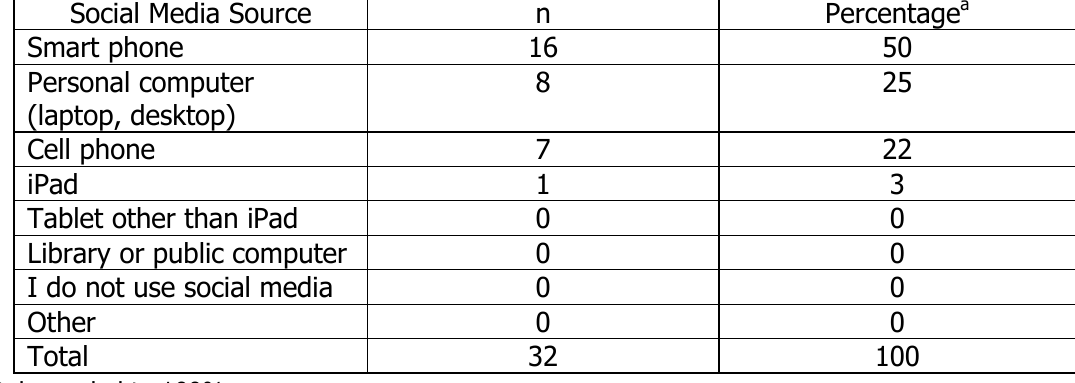
Primary Source used to Access Social Media as Reported by Louisiana 4-H Alumni that Completed the Zammit Social Media